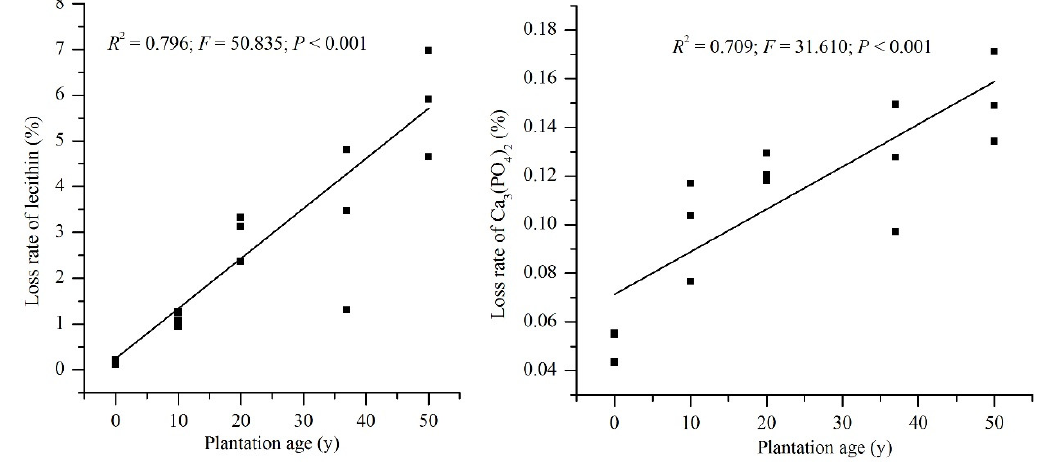
Figure 3. Responses of potentials of organic P mineralization and inorganic P solubilization to plantation development.